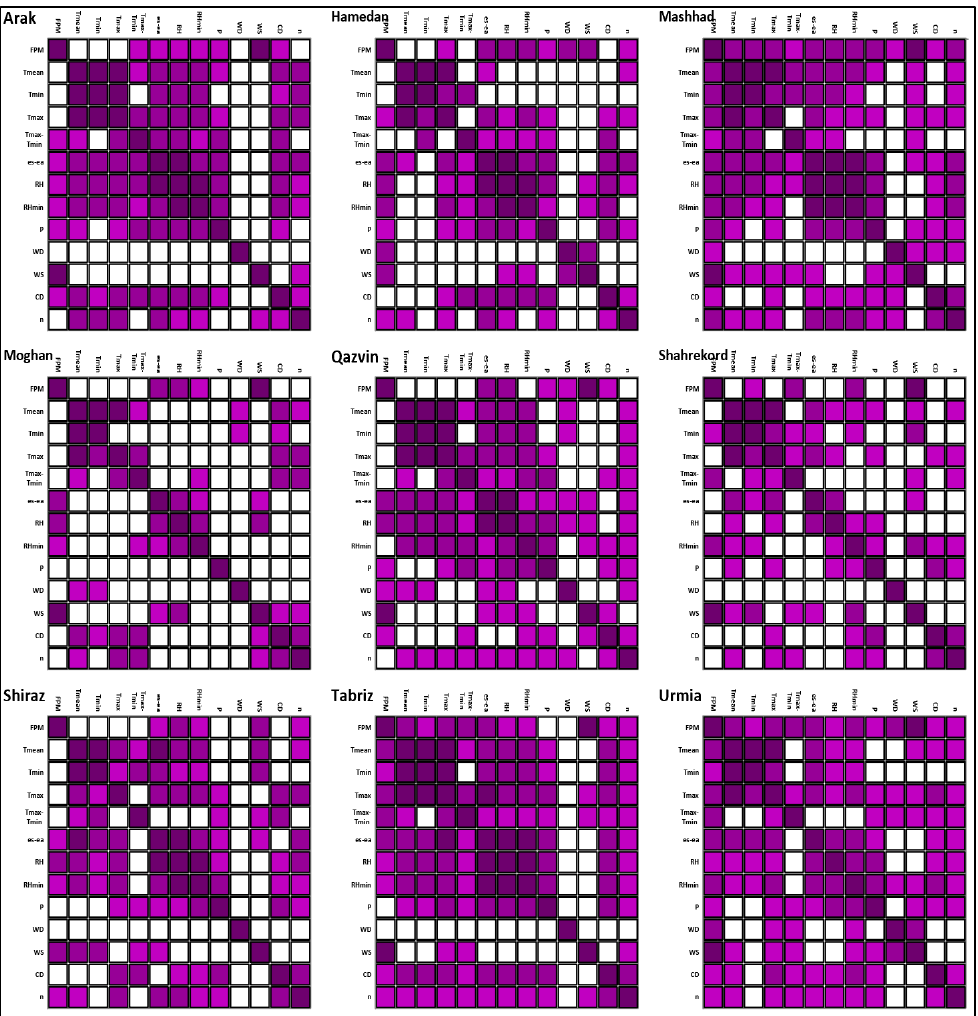
Figure 8. Spearman’s Rho correlation coefficient (ρ) maps for weather stations located in semiarid region. Colored boxes show a significant correlation at the confidence level of 95%. Dark, medium, and light purples denote 0.8 ≤ ρ ≤ 1, 0.5 ≤ ρ < 0.8, and ρ < 0.5, respectively.